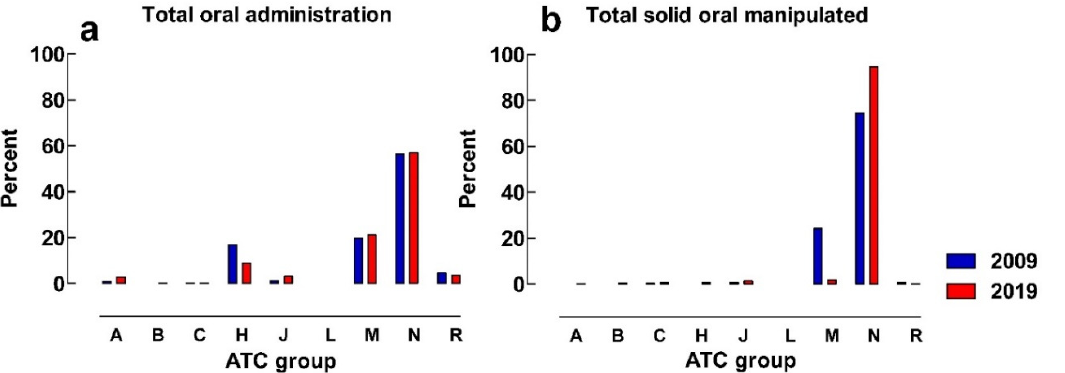
Figure 3. ( a ) Percentage of the distribution of total oral administrations between ATC-groups in the emergency department; ( b ) percentage of the distribution of solid oral manipulations between different ATC ‐ groups in the emergency department. A = alimentary tract, B = blood and blood forming organs, C = cardiovascular system, H = systemic hormonal preparations, J = anti ‐ infectives for systemic use, L = antineoplastic and immunomodulating agents, M = musculoskeletal system, N = nervous system, R = respiratory system.